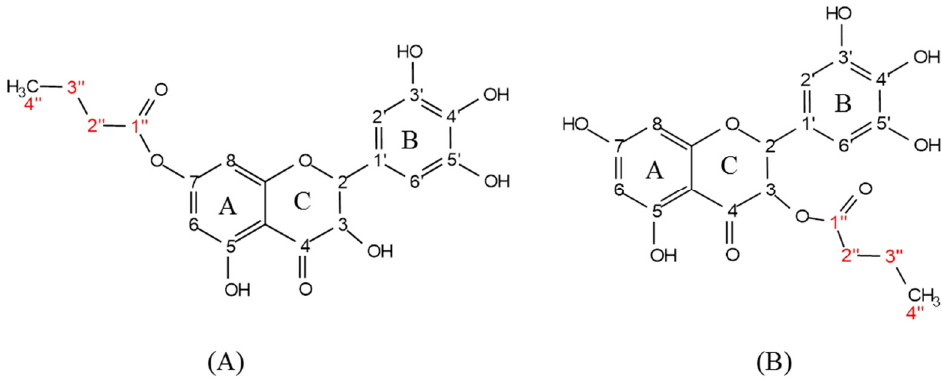
Figure 3. Structures of the DHM acylation products: ( A ) 7- O -butyryl-DHM and ( B ) 3- O -butyryl- DHM.